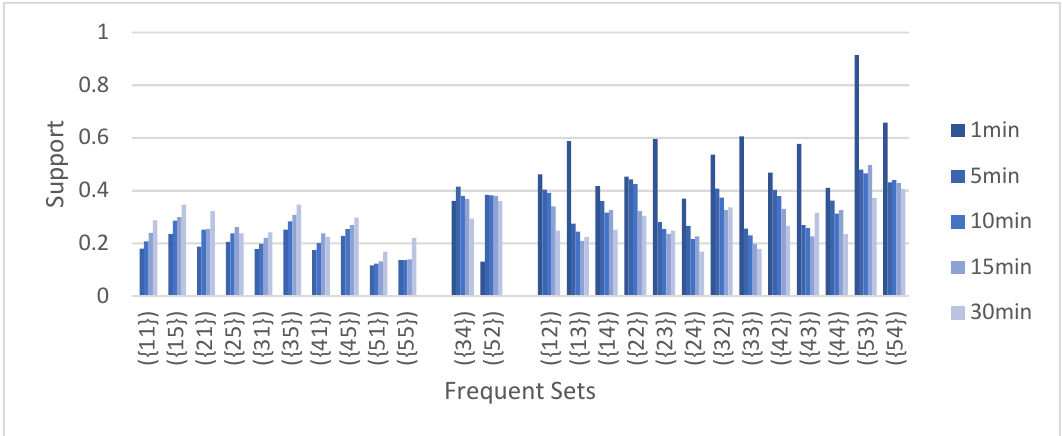
Figure 2. Frequent set distribution at different temporal granularity.